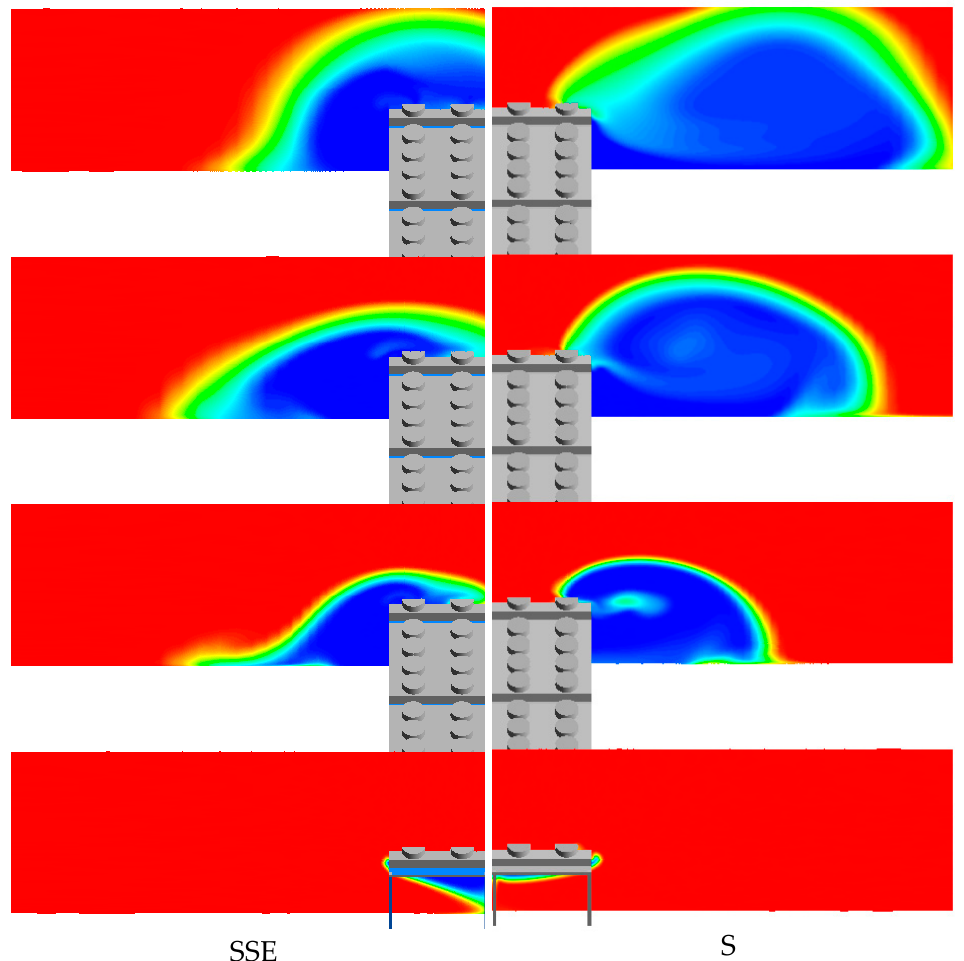
Figure 14. Temperature contour at different cross-sections (rows 1, 13, 25 and 37) for SSE (left) and S (right) wind directions, uniform field.